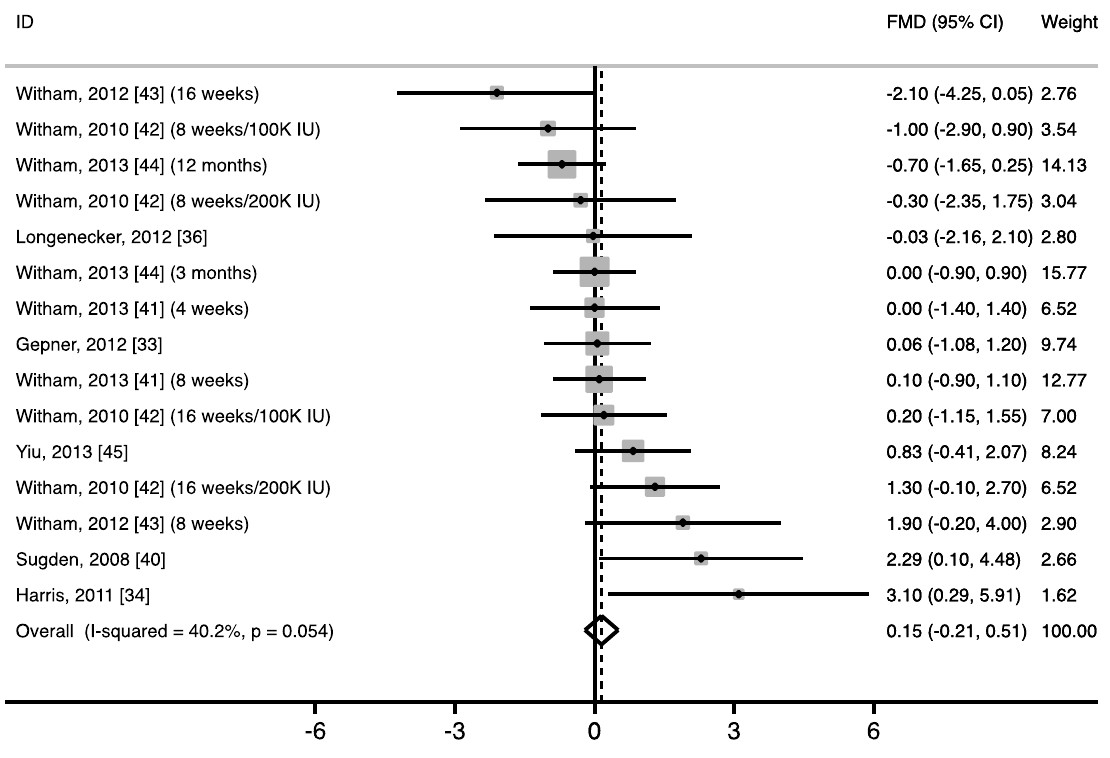
Figure 3. Forest plot of random controlled trials (RCTs) that investigated the effect of vitamin D supplements on flow-mediated vasodilation (FMD). The solid squares represent the weight of individual studies and the diamond represents the weighted mean difference (WMD) in FMD (calculated using fixed-effect meta-analyses). In all studies combined, vitamin D did not increase FMD (WMD: 0.15%; 95% CI: −0.21% to 0.51%; p =